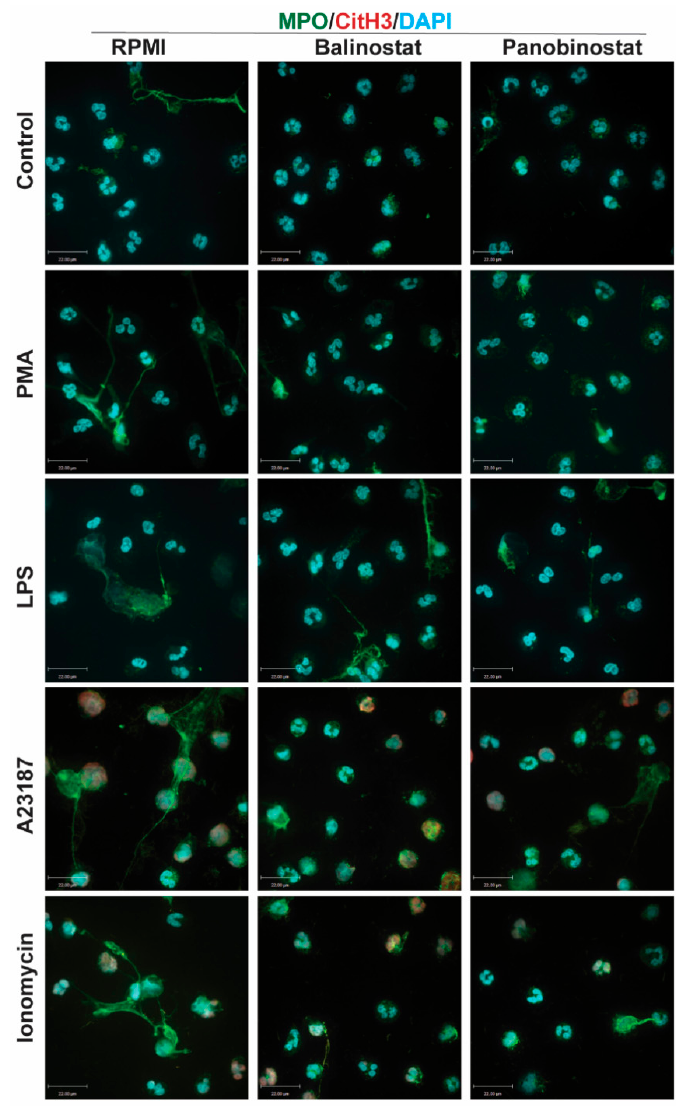
Figure 7. Confocal microscopy images confirm that HDACis promote cytotoxic e ff ects while inhibiting NOX-dependent and -independent NETosis. (A) Neutrophils were treated with negative control (RPMI), NETotic agonists (25 nM PMA; 4 µ M A23187; 5 µ g / mL LPS from Escherichia coli 0128; 5 µ